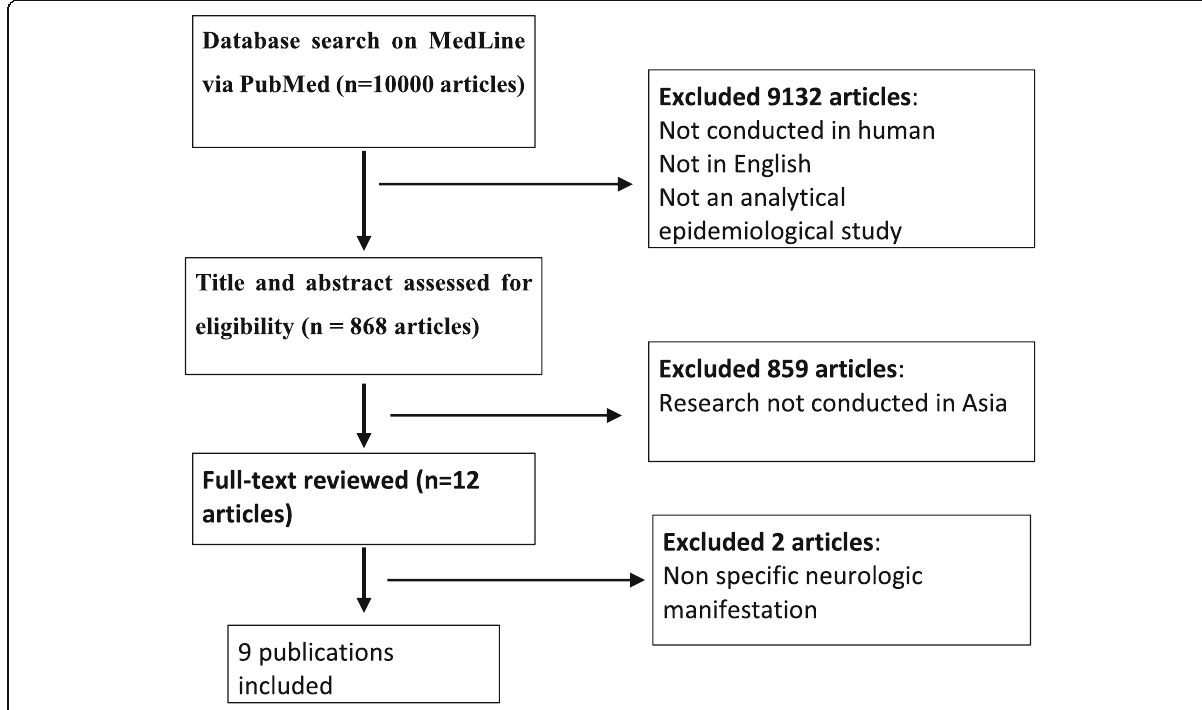
Fig. 1 Flow diagram of the stages of study selection for systematic